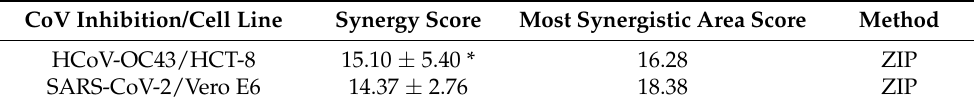
Table 2. The synergistic inhibition of coronaviral replication in HCoV-OC43-infected MRC-5 cells and SARS-CoV-2-infected Vero E6 cells after treatment with the combination of ciclesonide and dbq33b. CoV Inhibition/Cell Line